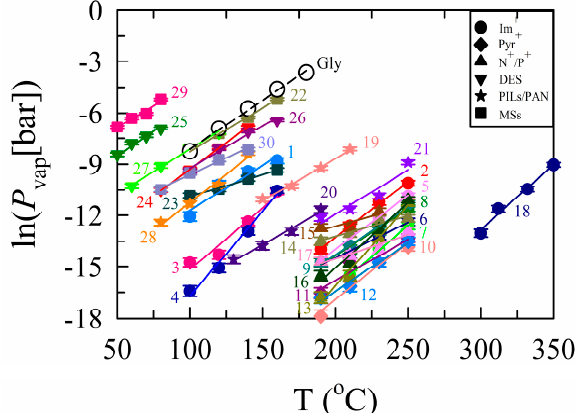
Figure 4. A map illustrating isothermal-gravimetry-determined temperature-dependent vapor pressure for representative ionic liquids (ILs), deep eutectic solvents (DESs), and miscellaneous low-volatility fluids. The individual solvents are identified numerically corresponding to the entries of Table S3 in the Supplementary Information. The solid lines connecting experimental values for a given liquid denote linear regression fits for vapor pressure data and are shown primarily to guide the eye.